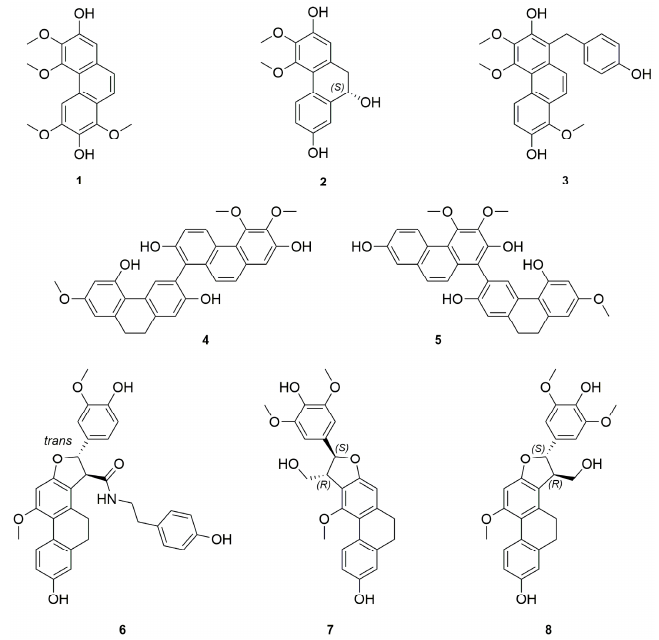
Figure 1. Chemical structures of compounds 1 – 8 from C. paniculatum pseudobulbs.